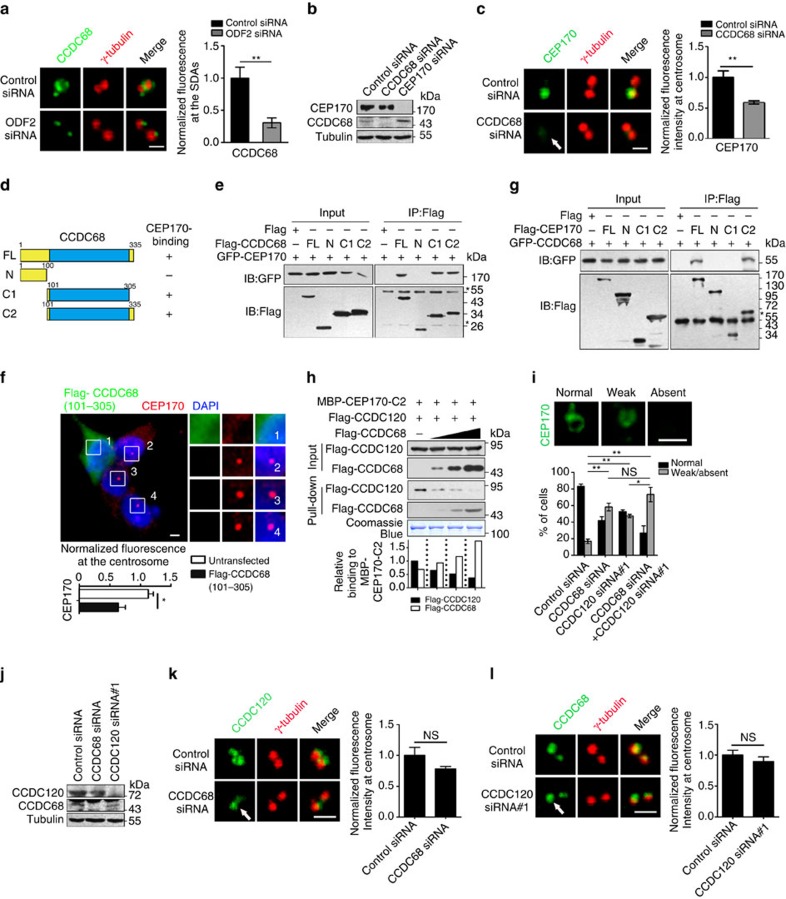
CCDC68 and CCDC120 competitively interact with CEP170.(a) Immunostaining of CCDC68 (green) and γ-tubulin (red) in control- or ODF2-siRNA-transfected U2OS cells. Quantification of CCDC68 at the SDAs are shown at right. (b) Immunoblots show depletion of CCDC68 and CEP170 by siRNA in U2OS cells. (c) Immunostaining of CEP170 (green) and γ-tubulin (red) in control- or CCDC68-siRNA-transfected U2OS cells. Arrow, centrosome localization. Quantification of CEP170 at centrosomes are shown at right. (d) Schematic of CCDC68. FL, full-length; coiled-coil domains, blue; +, positive; −, negative. (e) Lysates of HEK293T cells co-overexpressing GFP-CEP170 and Flag-CCDC68 truncates were subjected to immunoprecipitation (IP) and immunoblotted (IB) with the indicated antibodies. Asterisks, IgG bands. (f) Immunostaining of U2OS cells overexpressing Flag-CCDC68 (101–305 aa) with anti-Flag (green) and anti-CEP170 (red) antibodies. DNA, 4,6-diamidino-2-phenylindole (DAPI; blue). Centrosomes are magnified. Quantification of CEP170 at centrosomes is shown below. (g) Lysates of HEK293T cells co-overexpressing GFP-CEP170 and Flag-CCDC68 truncates were subjected to IP and IB with anti-GFP and anti-Flag antibodies. Asterisk, IgG. (h) Lysates of HEK293T cells overexpressing Flag-CCDC120 or Flag-CCDC68 were subjected to pull-down assays with MBP-CEP170-C2 (1,015–1,460 aa). Quantification of the Flag-CCDC68 and Flag-CCDC120 band intensity (normalized to MBP-CEP170-C2) in three independent experiments are shown on the graph. (i) Quantification of the fluorescence intensity of CEP170 at centrosomes in the indicated siRNA-transfected U2OS cells. (j) Immunoblots show depletion of CCDC68 and CCDC120 by siRNA in U2OS cells. (k) Immunostaining of CCDC120 (green) and γ-tubulin (red) in control- or CCDC68-siRNA-transfected U2OS cells. Arrow, centrosome localization. Quantification of CCDC120 at centrosomes are shown at right. (l) Immunostaining of CCDC68 (green) and γ-tubulin (red) in control- or CCDC120-siRNA-transfected U2OS cells. Arrow, centrosome localization. Quantification of CCDC68 at centrosomes are shown at right. For a,c,f,i,k and l scale bars, 1 μm. Data in a,c,f,i,k and l are the mean±s.e.m. n>100 cells from three individual experiments, Statistical significance was determined by a two-sided Student's t-test. *P<0.05, **P<0.01; NS, not significant. Unprocessed original scans of immunoblots are shown in Supplementary Fig. 7.